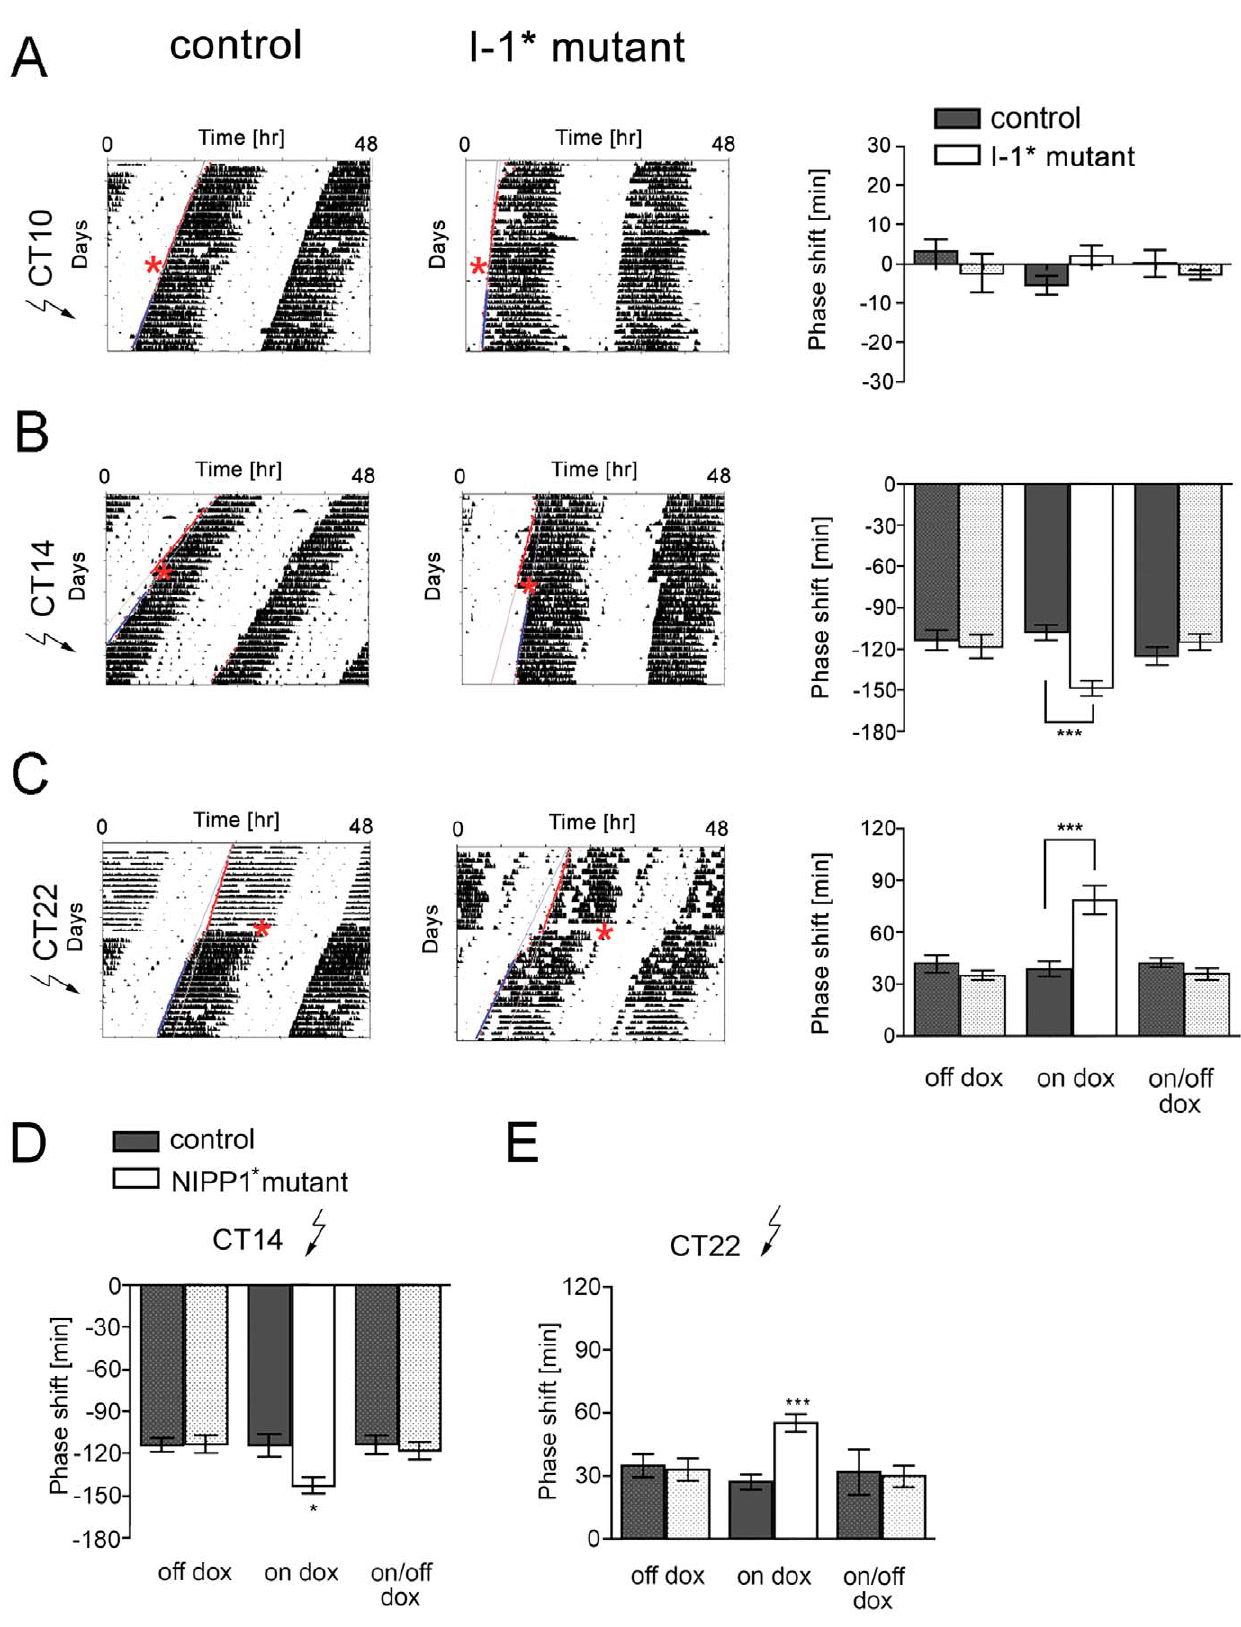
Figure 3. Light-induced resetting is altered in I-1* and NIPP1* mutant mice. (A–C) Shown are representative locomotor activity records before and after a 15-min light pulse of control (left panels) and I-1* mutant mice (middle panels) under on dox conditions. Red asterisks indicate the timing of the light pulse. The light pulse was administered at CT10 (A) (off dox n=8 control, n=3 mutant; on dox n=20 control, n=12 mutant; on/off